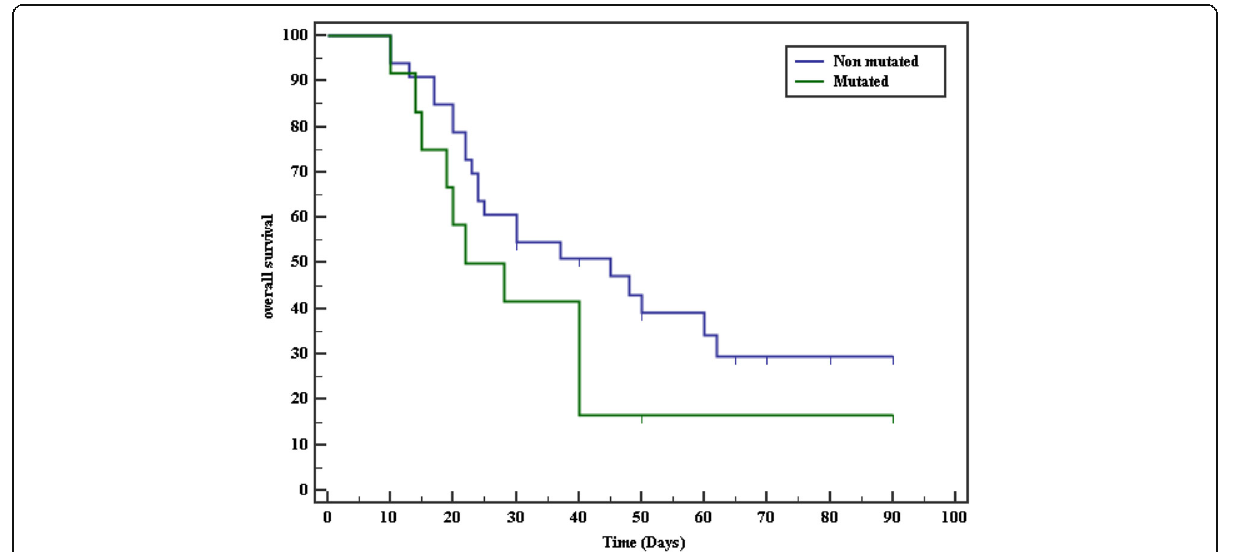
Fig. 4 Kaplan-Meier survival curve for overall survival in relation to DNMT3A